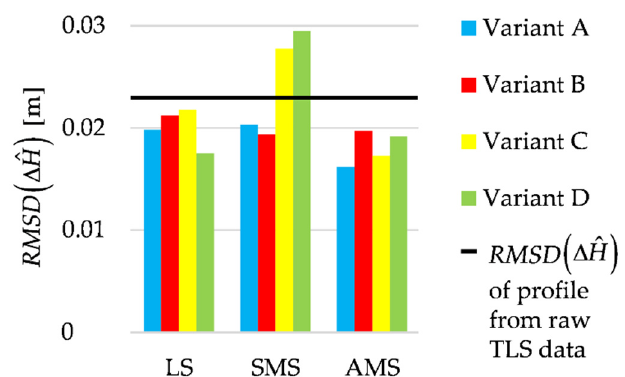
Figure 15. Lines III and IV; accuracy of the differences between the estimated profiles compared to accuracy of the differences obtained from raw TLS data.